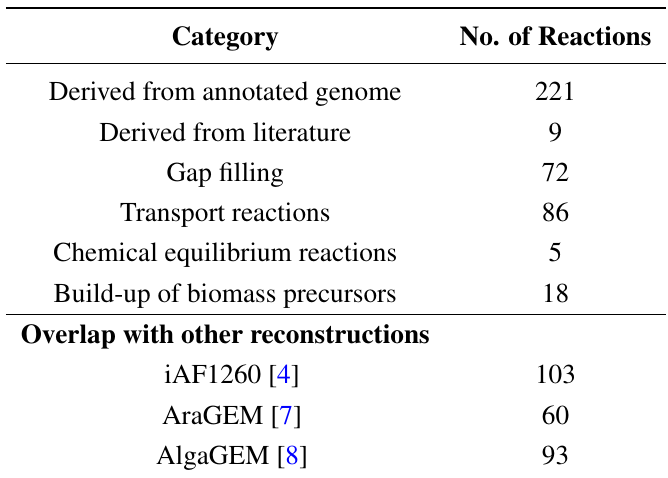
Table 1. Categories of reactions included in the metabolic network. Note that reactions can fall into several